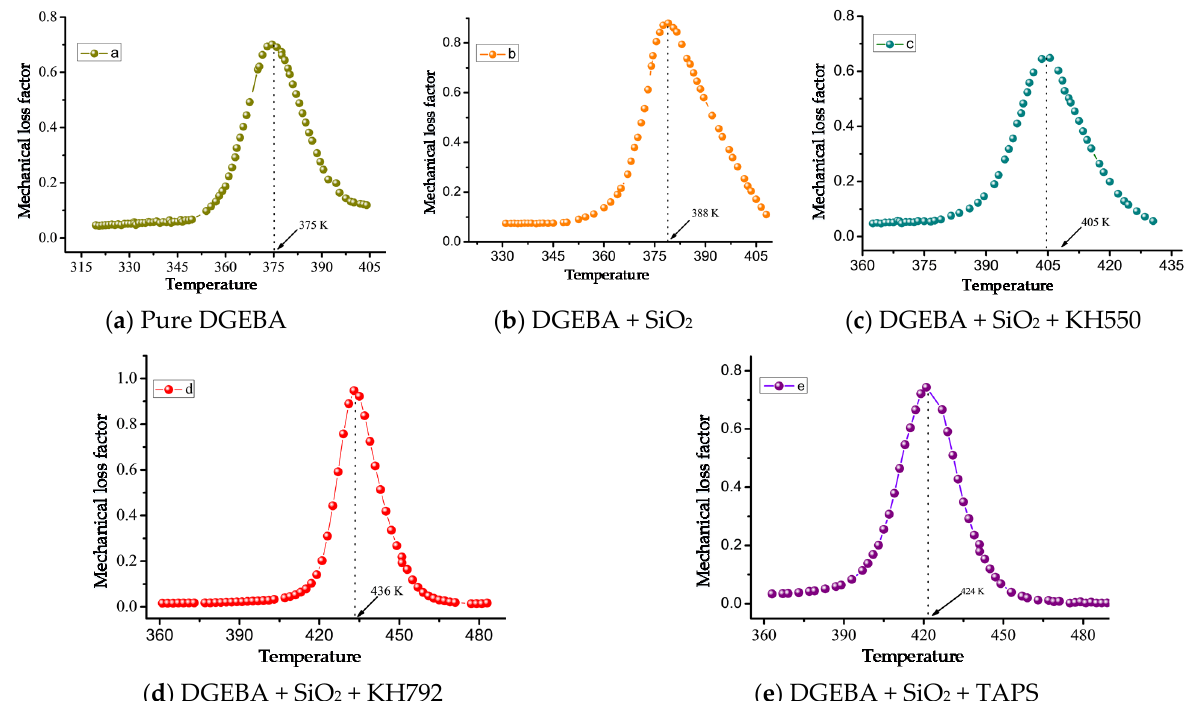
Figure 4. Mechanical loss factor for five samples under different temperatures.